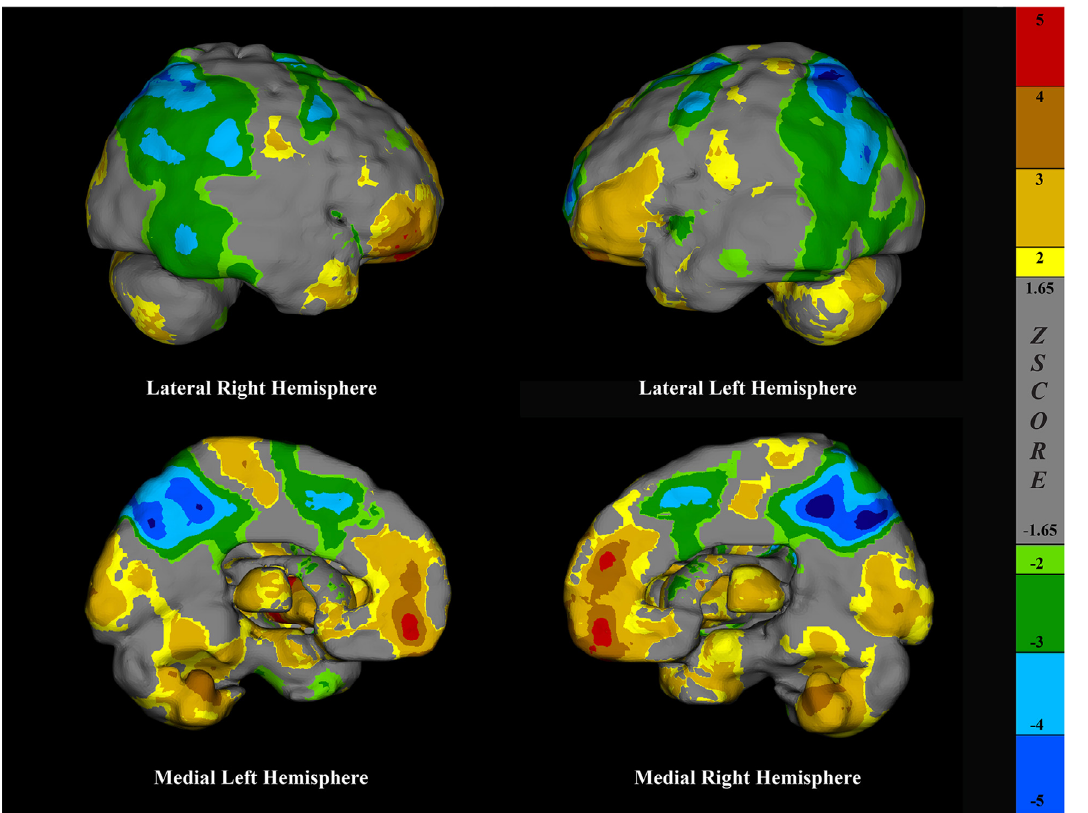
Figure 9. Surface projections of a brain SPECT scan rendered in CereMetrix ® demonstrating temporal parietal hypoperfusion in a person with suspected